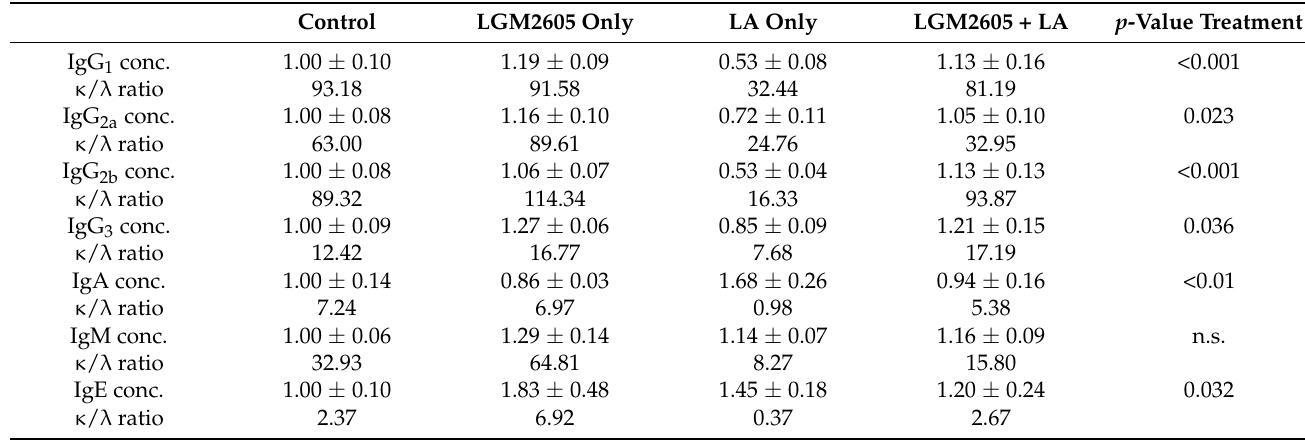
Table 1. PLF immunoglobulin isotypes by cytometric bead array. Immunoglobulin concentrations are presented as relative concentration ± standard error, using saline control as standard. κ / λ ratios are presented as mean concentration κ antibody/mean concentration λ antibody for each isotype. In general, LA treatment decreased κ / λ ratios; treatment with LGM2605 + LA restored κ / λ ratios to control levels. Data were analyzed via two-way ANOVA to analyze overall treatment effects (sex differences not